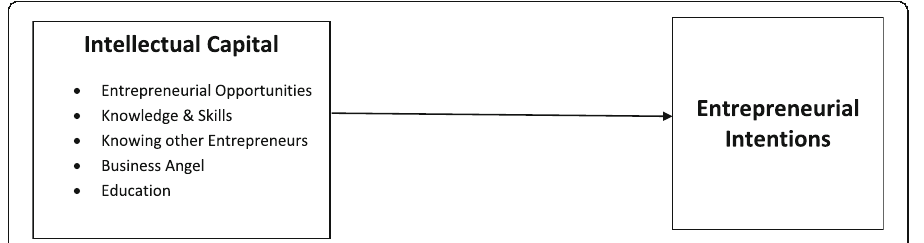
Fig. 1 Relationship between the components of intellectual capital with entrepreneurial intentions